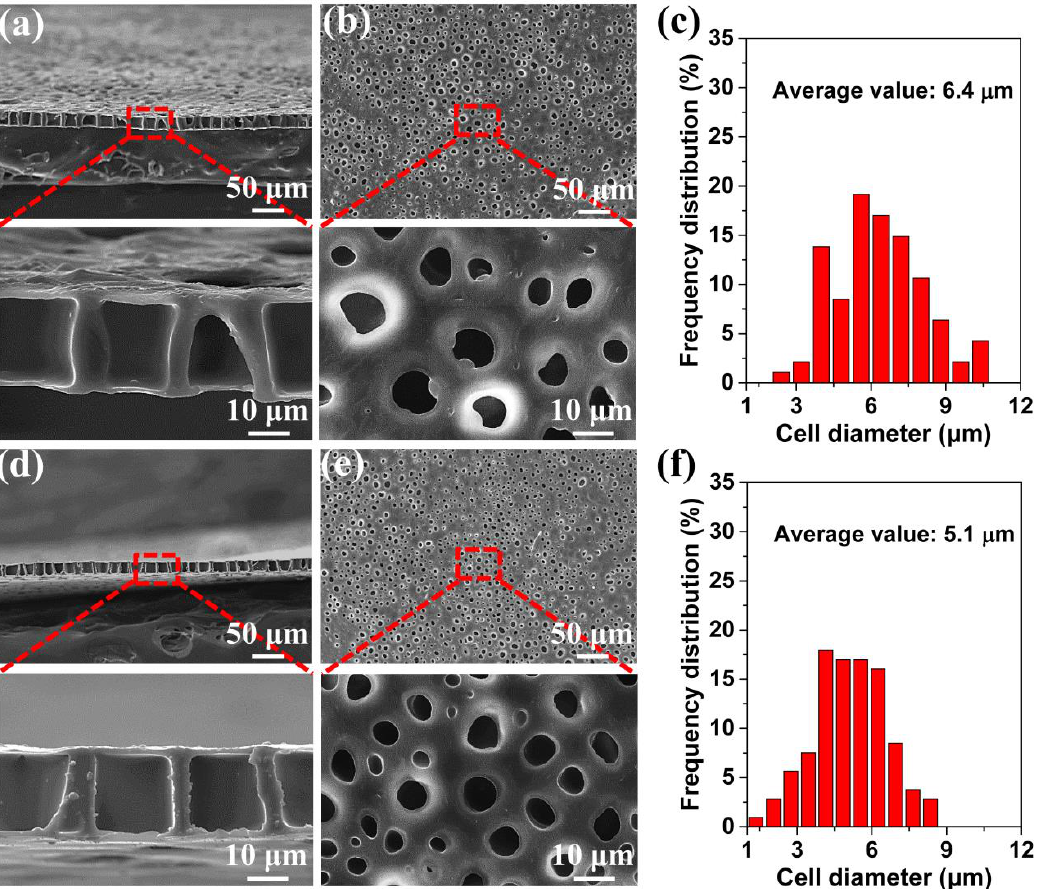
Figure 4. SEM images of the prepared TPU perforated membranes, the films were saturated under 2.5 MPa ( a – c ) and 3.0 MPa ( d – f ), respectively, and then were foamed at 120 C for 10 s. ( a, d ) the